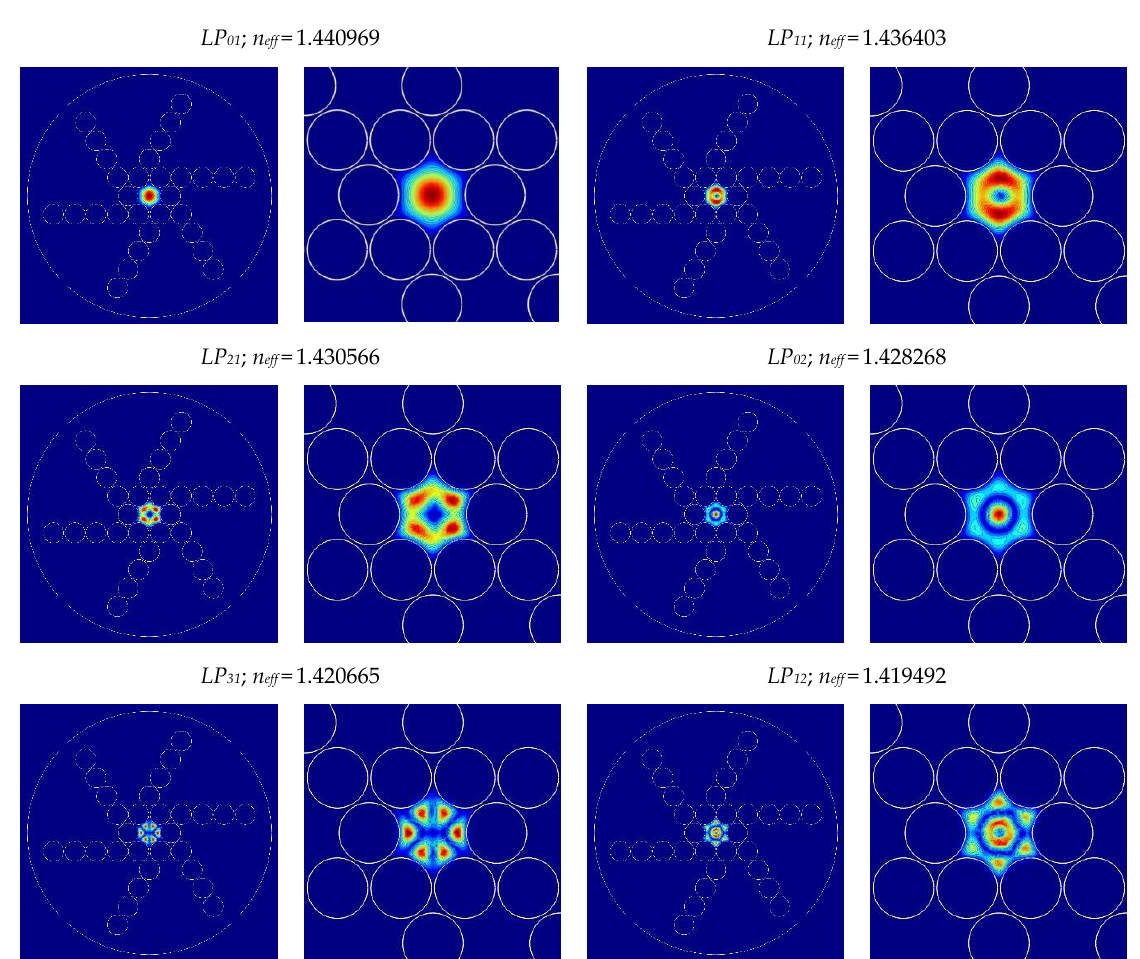
air holes; ( b ) pitches. ( a )